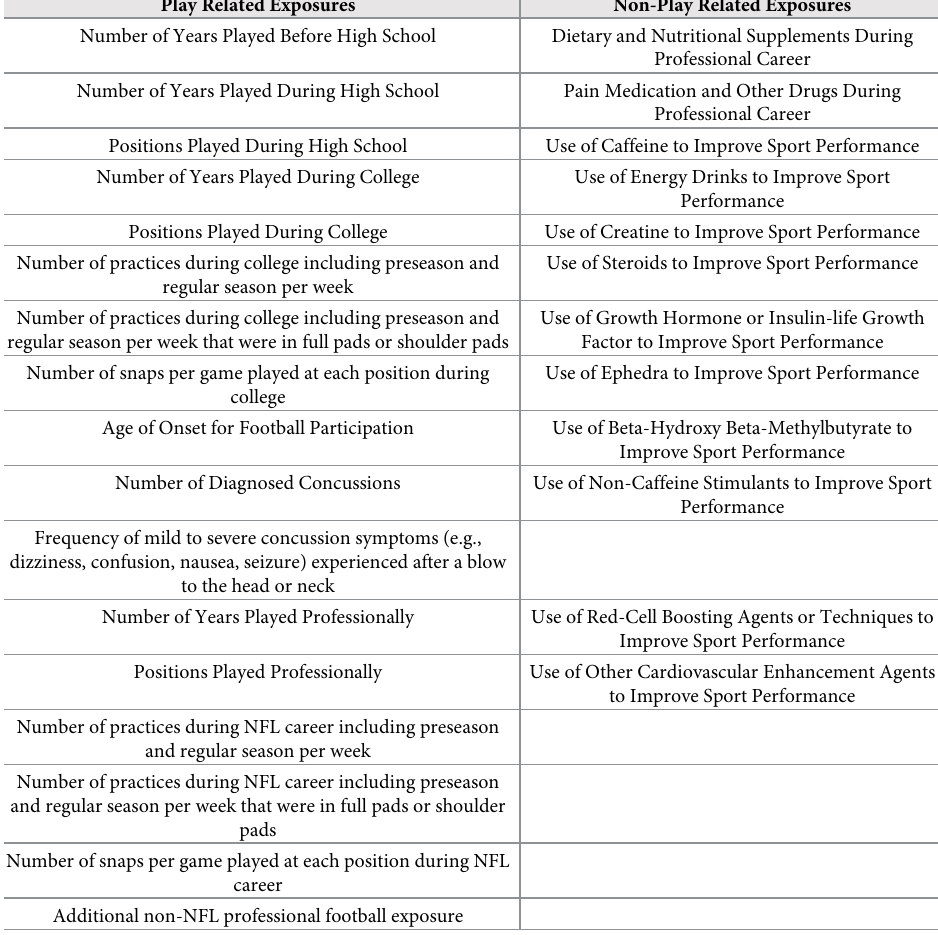
Table 2. American-style football exposure metrics and non-American-style football exposure metrics measured in the Football Players Health Study’s In-Person